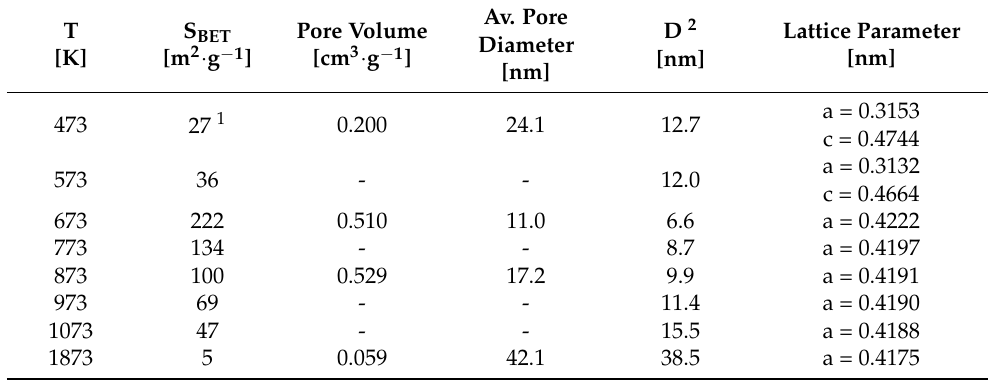
Table 1. Textural properties of MgO-T samples calcined at various temperatures.